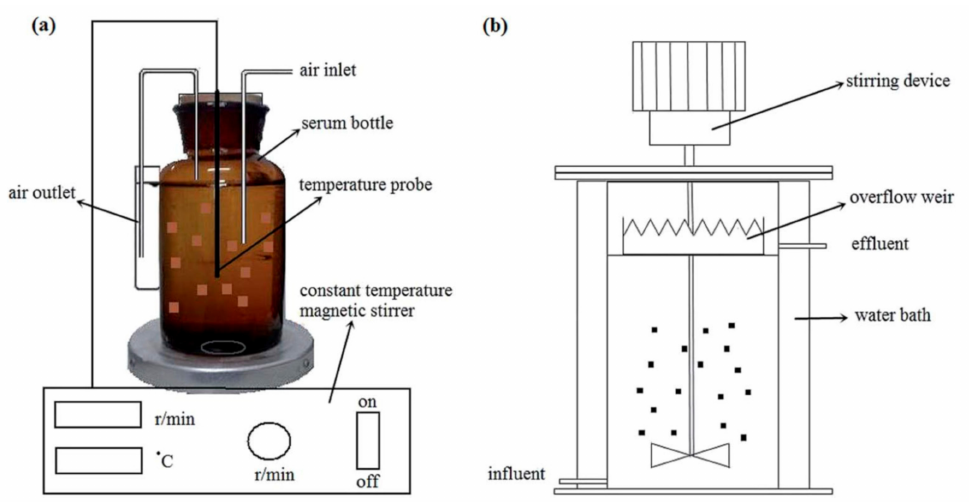
Figure 11. ( a ) Apparatus for measuring anammox performance. ( b ) Stirred continuous-flow reactor [47]. Copyright © (2015) Royal Society of